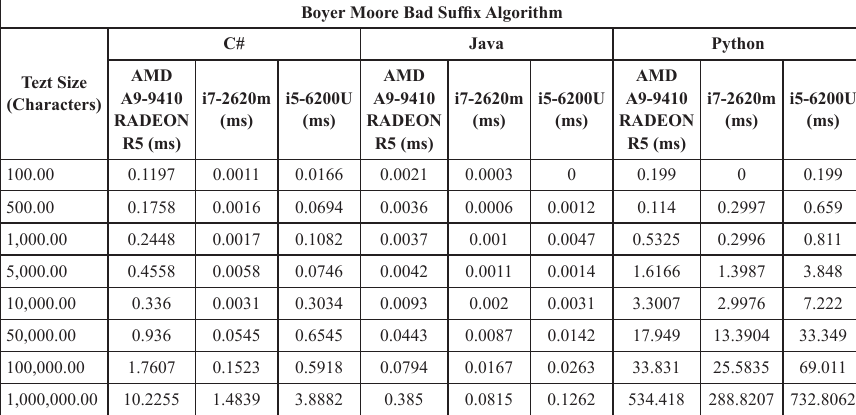
Table 5. Running time of Boyer Moore Bad Suffix algorithm in C#, Java and Python programming languages